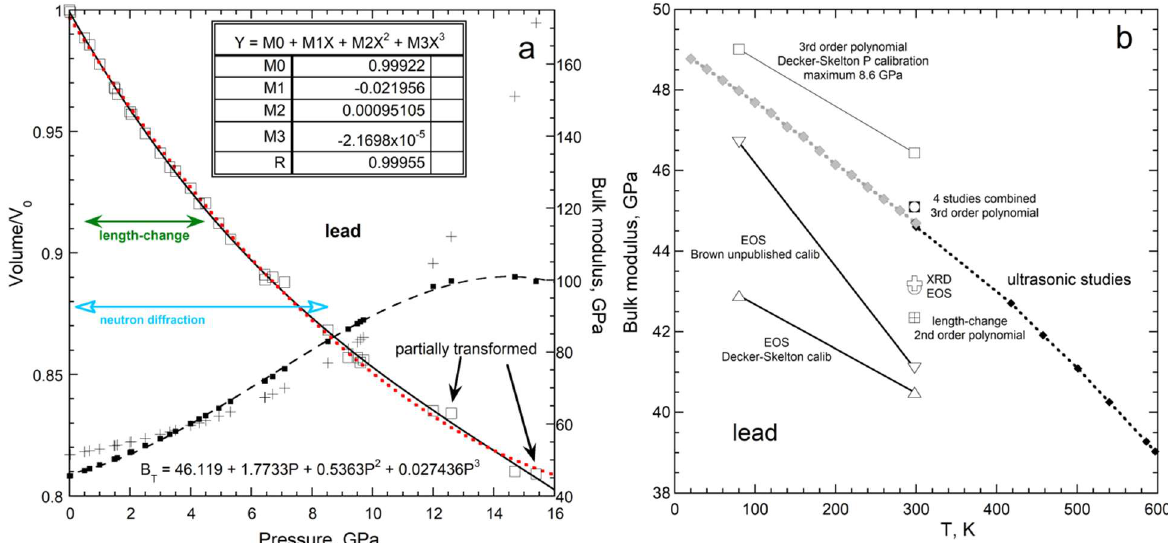
Figure 8. Lead volumes and bulk moduli, mostly from DAC studies: ( a ) polynomial fit combines results from [31,49–51]. Double arrows denote pressure ranges. XRD experiments probed the whole stability field (to 16 GPa) but with few data points. Dotted curve = the 2nd order fit to V , where + = the corresponding B ( P ). Inset lists the 3rd order fit to V vs. P (solid curve), with filled squares for the resulting B ( P ), which is fit to the listed 3rd order polynomial. This fit gives slightly higher initial B than calculation; ( b ) temperature dependence of bulk moduli. Diamonds = B aco (grey from [52]; black from [53]). Square in circle = result from panel a. Open squares and various triangles = several fits to neutron diffraction data [51], as labelled. Other open symbols = reported EOS values of